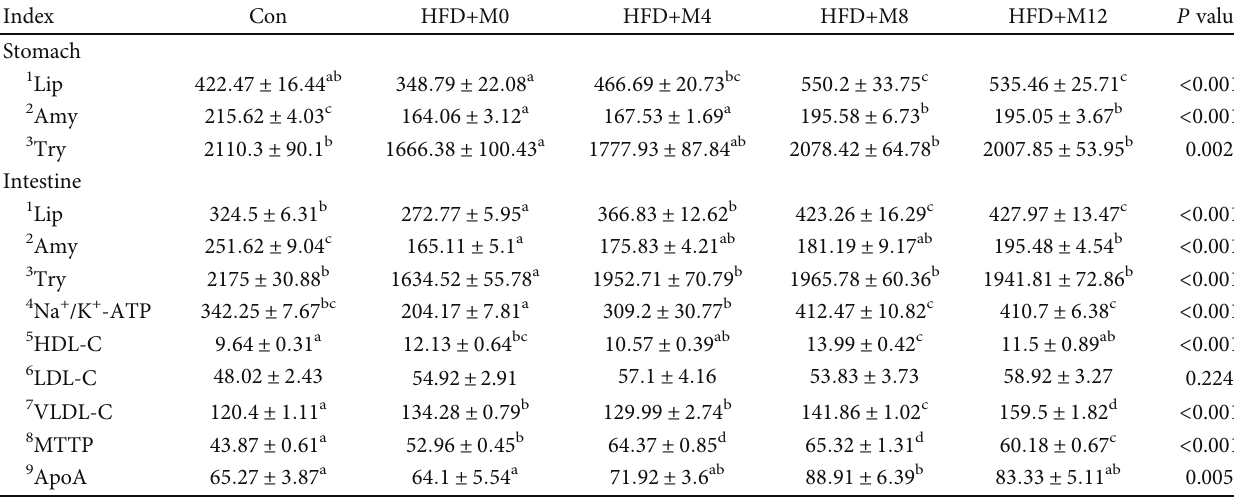
Table 5: E ff ects of high-fat diet supplemented di ff erent levels of methionine on gastric and intestinal biochemical indices.